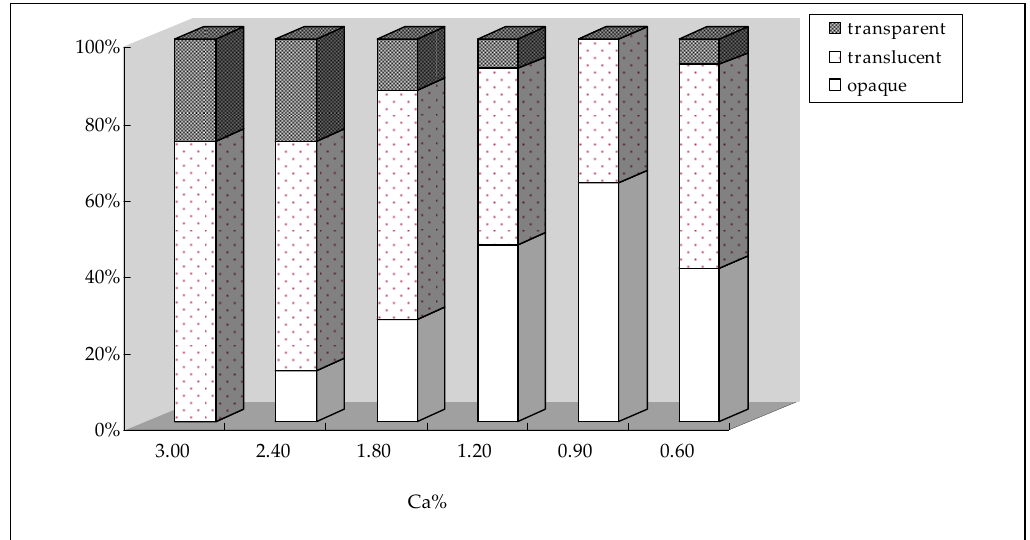
Figure 2. The distribution of transparent, translucent and opaque eggs between different Ca levels at 16 w.